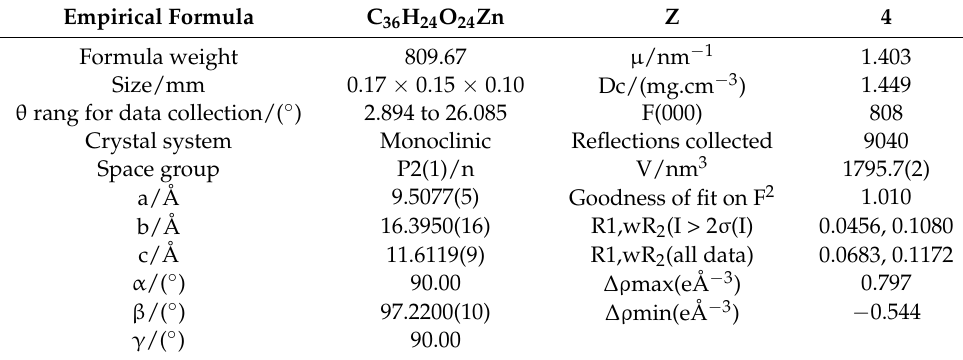
Table 1. Crystal data of MOF Zn(BTC) 4